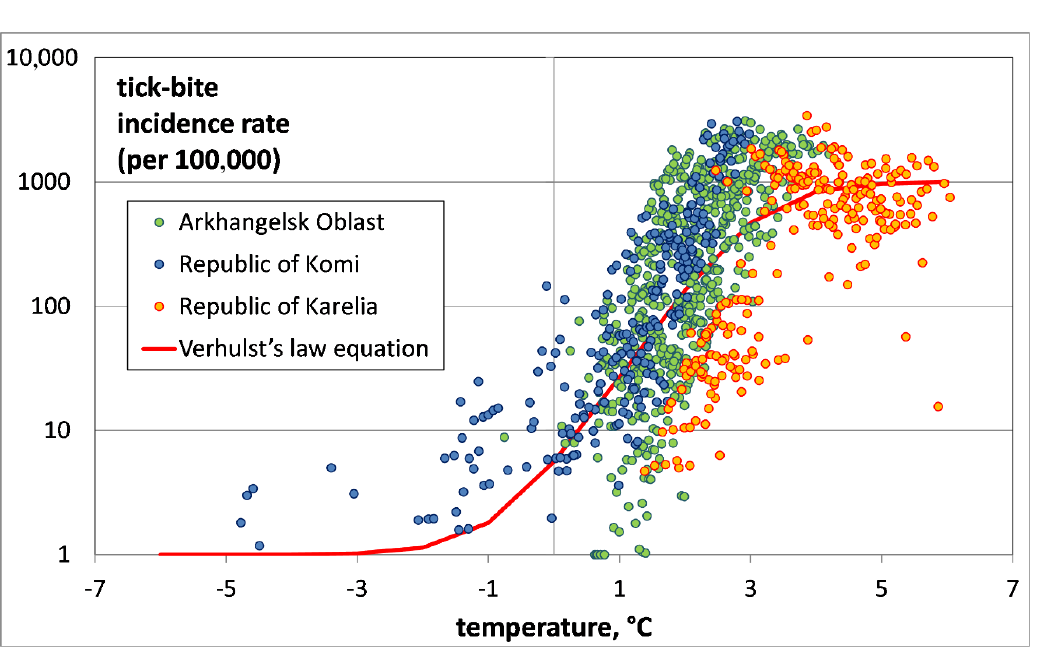
Figure 6. Regional distribution of tick-bite incidence rate versus average annual model air temperature for all administrative units of the Arkhangelsk Oblast, Karelia and Komi.